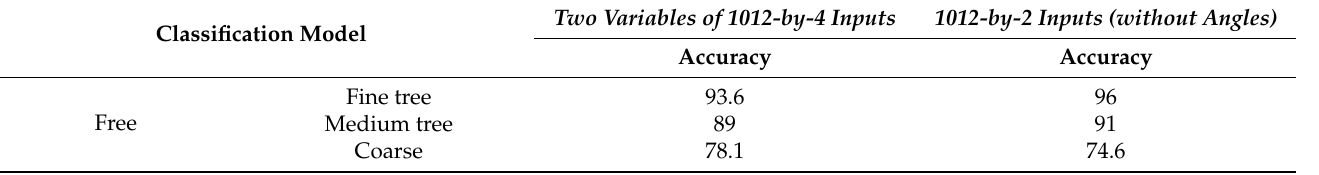
Table 4. Outcomes of experiments on Machine Learning models: Accuracy results for different classification learning